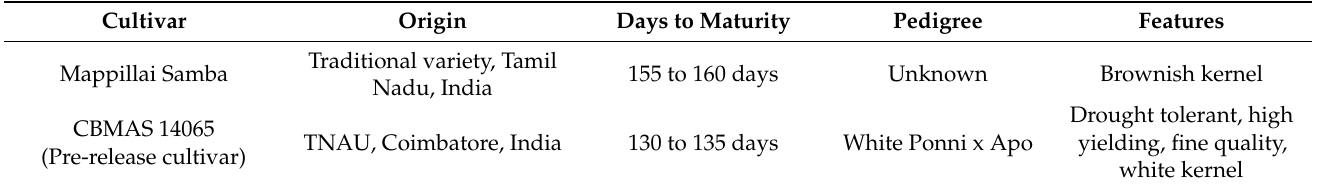
Table 1. Details of the agronomic characteristics of rice genotypes CBMAS 14065 and Mappillai